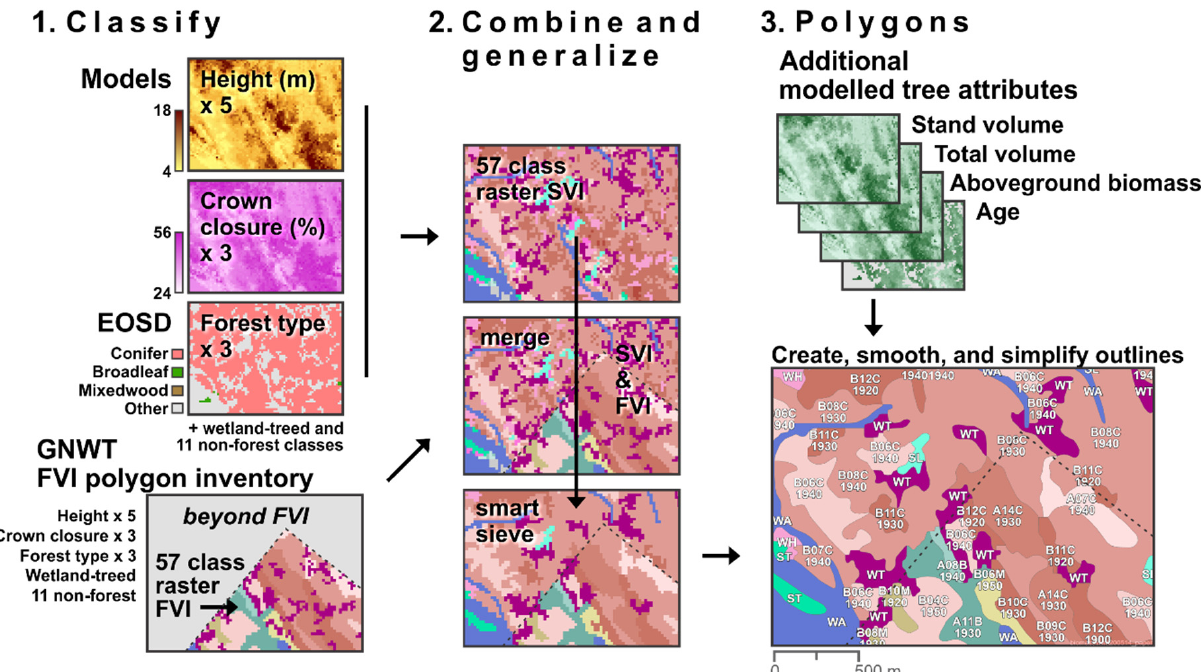
Figure 3. Overview of the spatial generalization of the raster maps into polygons in the vector version of the Multisource Vegetation Inventory produced in this study (MVIv). The dashed grey line in the lower insets represents the virtual seamline between the Forest Vegetation Inventory (FVI) and the Satellite Vegetation Inventory (SVI), which does not exist in the final vector product. For forest polygons, the first letter in the label indicates the crown closure class, the next 2 digits are the mean stand height, the last letter is the broad forest type, and the 4 digits below are the origin year (e.g., B11C means a conifer stand of 11 m height and crown closure class B–26%–55%). EOSD is the Earth Observation for Sustainable Development of Forests; GNWT is the Government of the North- west Territories.